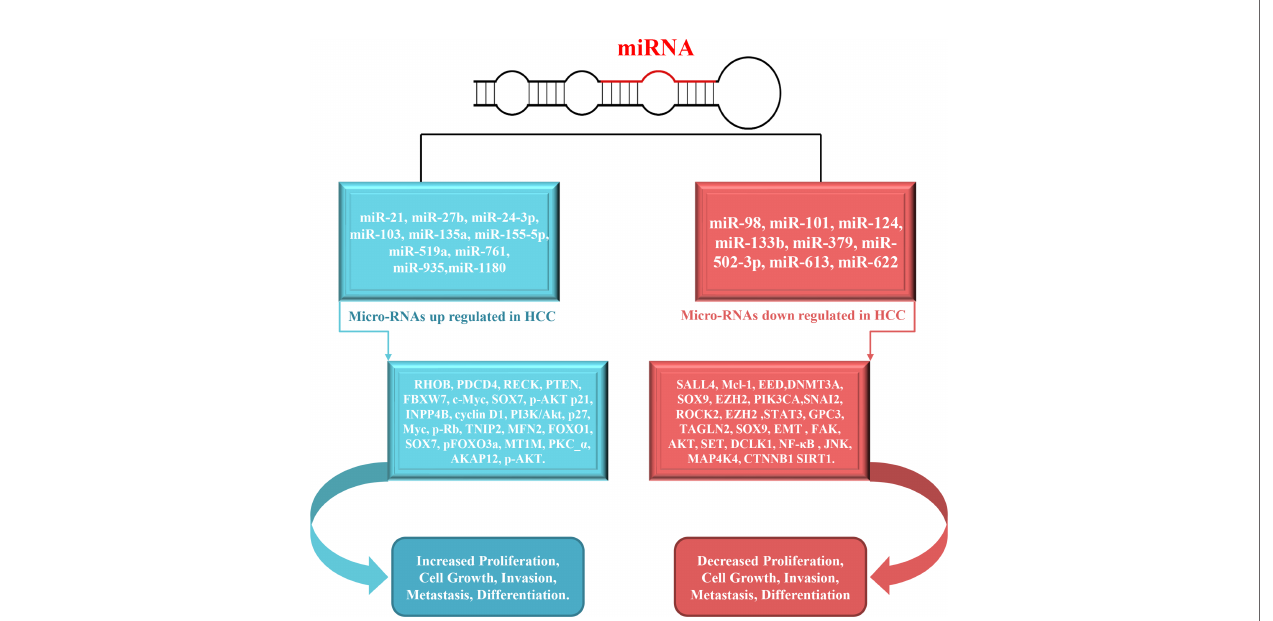
FIGURE 3 | Schematic overview of miRNAs involved in the metastasis, proliferation, migration and invasion in HCC. The inhibition of validated targets (left side) by speci fi c miRNAs results in increased metastasis, proliferation, migration and